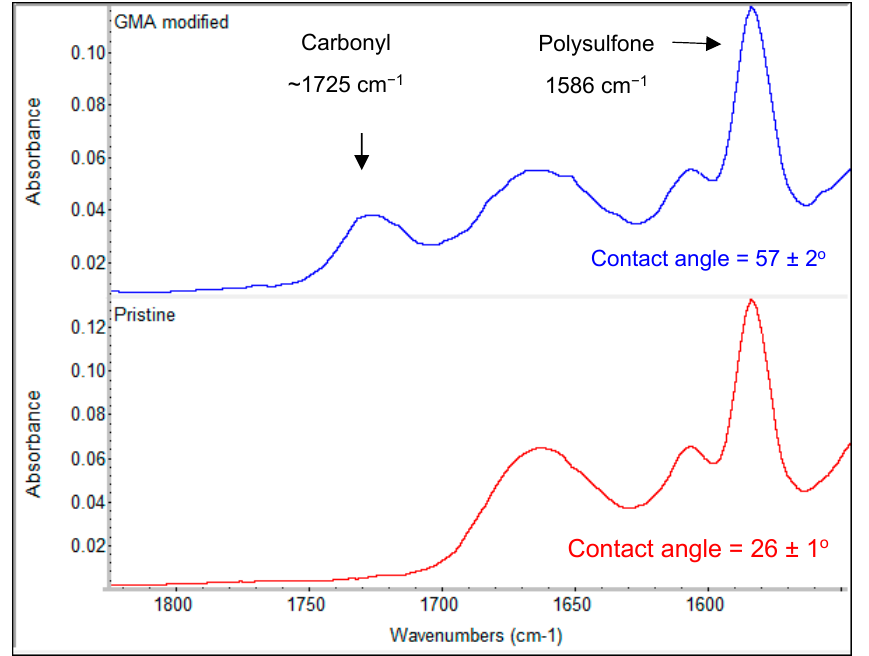
Figure 2. Typical spectra of a pristine ESPA1 membrane ( bottom ) and a membrane modified by grafting a poly(glycidyl methacrylate) (GMA) coating layer ( top ).